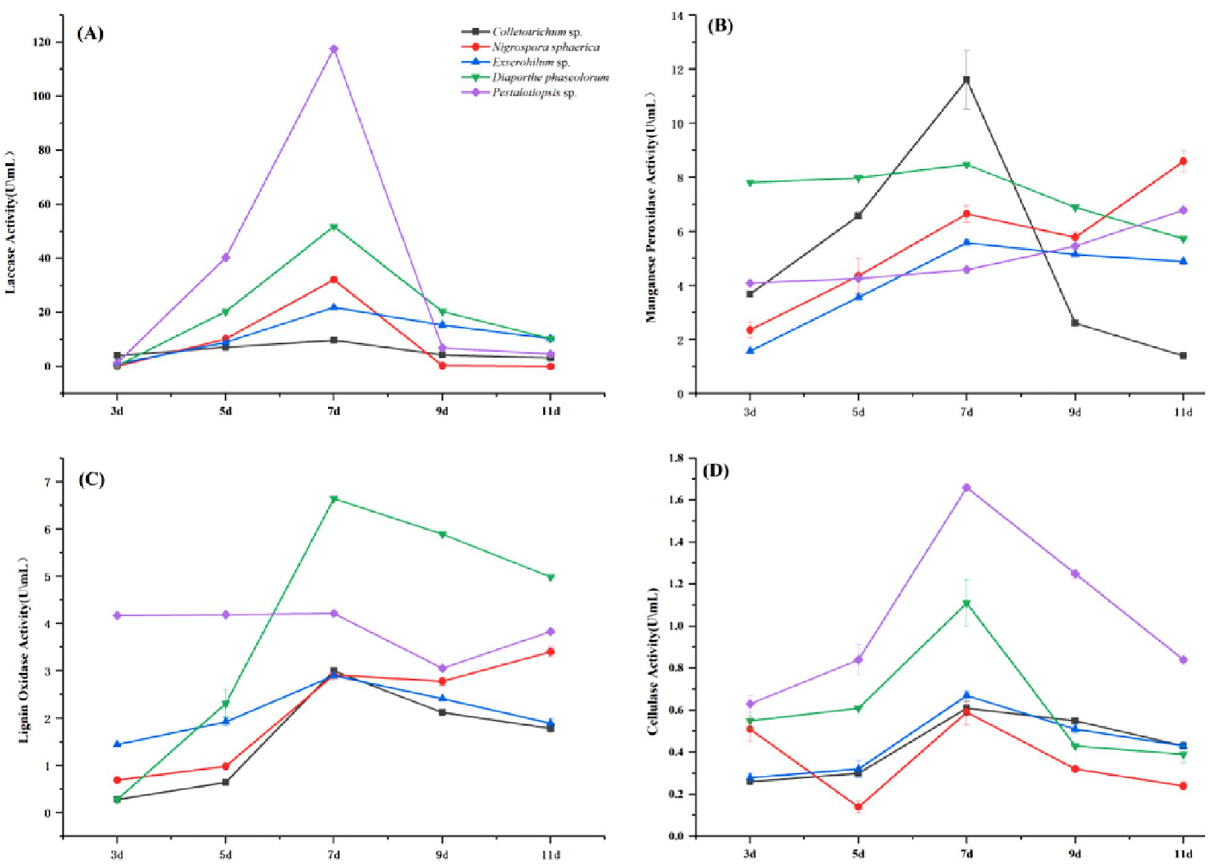
Figure 4. Variations of relevant enzyme activities produced by different endophytic fungi over time during lignin and cellulose degradation: ( A ) laccase activity; ( B ) manganese peroxidase activity; ( C ) lignin oxidase activity; ( D ) cellulase activity. Strain Pestalotiopsis